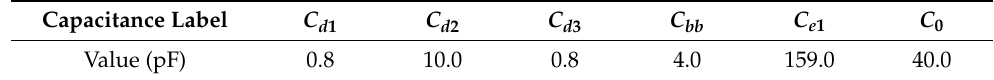
Table 6. Distributed capacitance